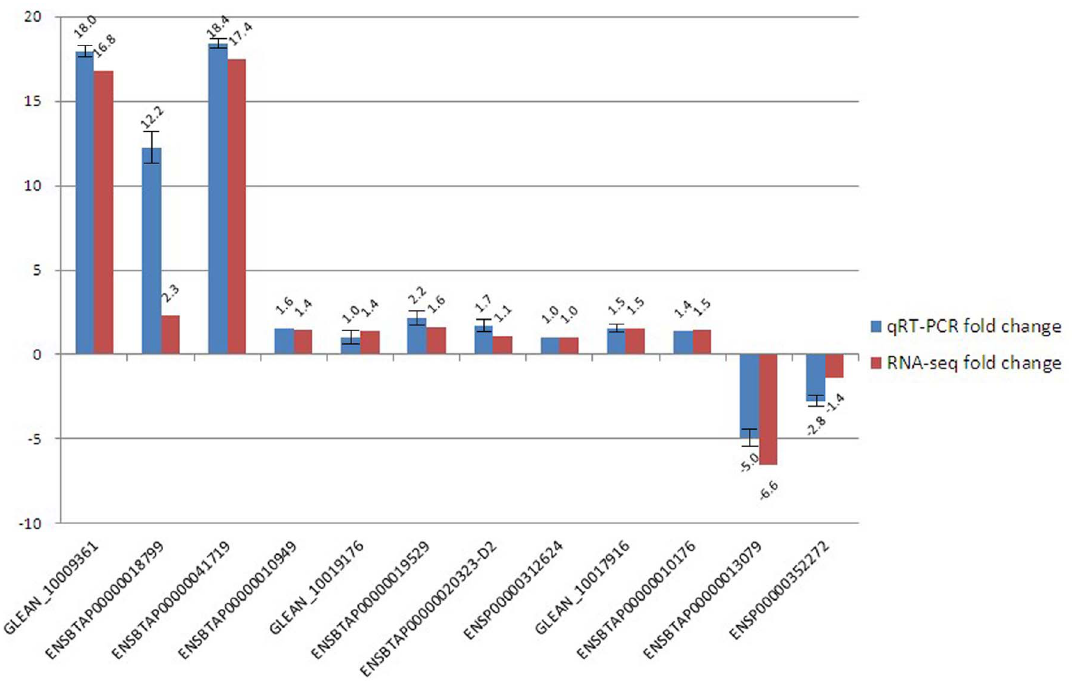
Figure 3. qRT-PCR validation of the expressed genes using the Illumina sequencing technology. For the 12 randomly selected differentially expressed genes, fold changes of DP/SH determined from the relative Ct values of using the 2 2 DD CT method in qRT-PCR were compared to those detected by RPKM of DP/SH in RNA-seq. All Ct values were normalized to GAPDH and replicates (n=3) of each sample were run.